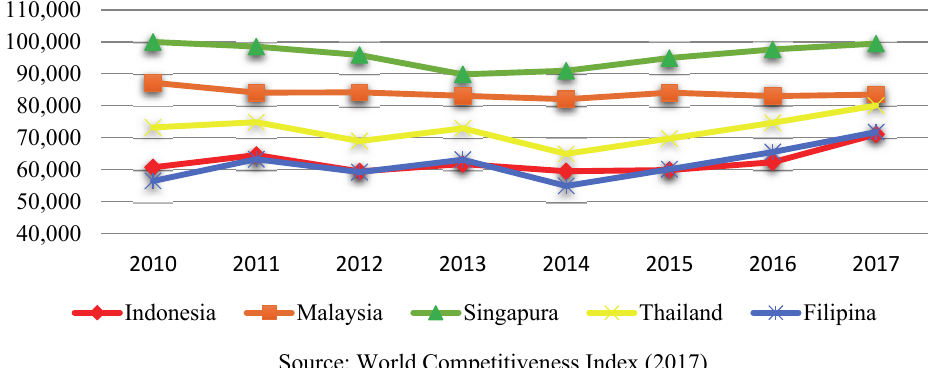
Fig. 1. Indonesia's competitiveness ranking of the five ASEAN countries 2010-2017